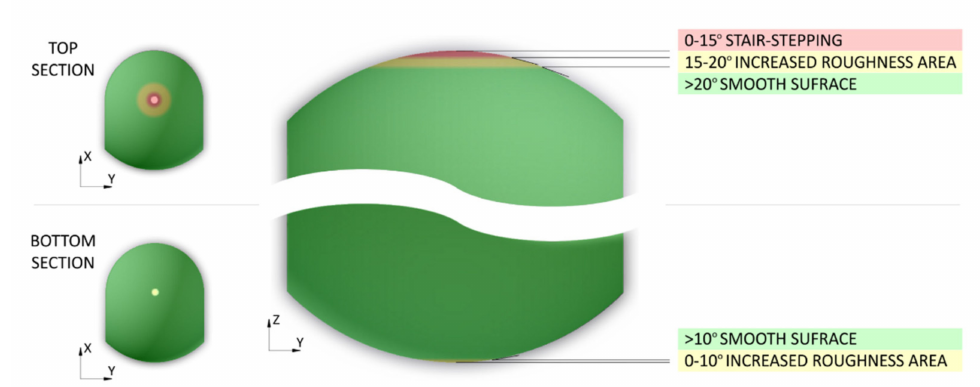
Figure 19. The occurrence potential for stair-stepping on the example of parts printed in orientation 4.